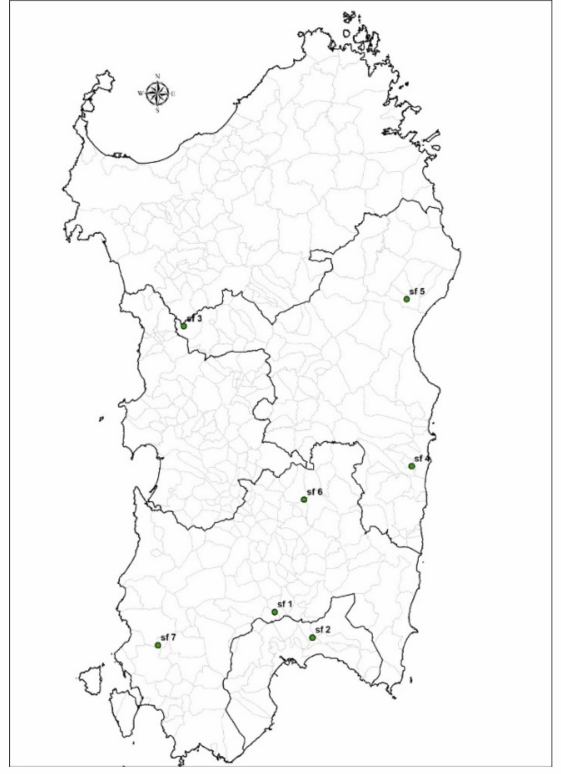
Figure 1. Geographical locations of the seven snail